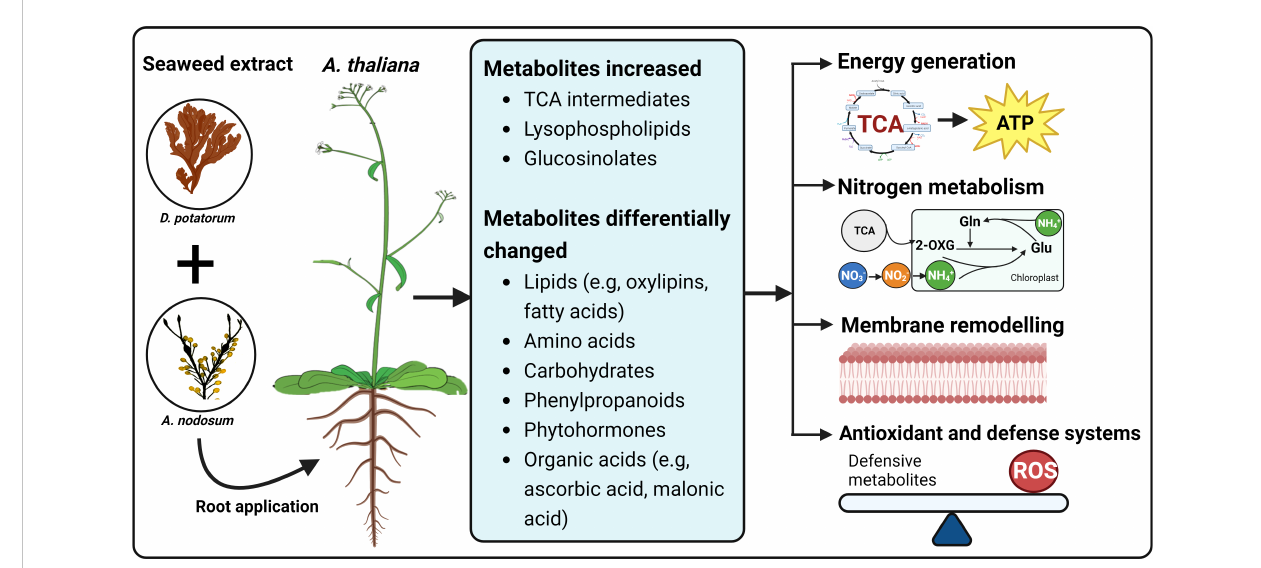
FIGURE 9 A summary of changes in Arabidopsis metabolic pro fi les induced by seaweed extracts. The SWE, derived from D. potatorum and A. nodosum were twice applied to Arabidopsis roots and metabolic changes were observed after 0, 3, and 5 days after the second treatment. We demonstrated that SWE triggered changes in various important metabolite groups such as lipids, amino acids, carbohydrates and phytohormones. Signi fi cant accumulations of essential growth and defence-related metabolites such as TCA cycle, lysophospholipids and glucosinolates were also detected in both SWE-treated leaves and roots. All these metabolic changes may contribute to enhancing energy production, carbon and nitrogen metabolism, remodeling of cell membranes and improving antioxidant and defence systems. The fi gure was generated using